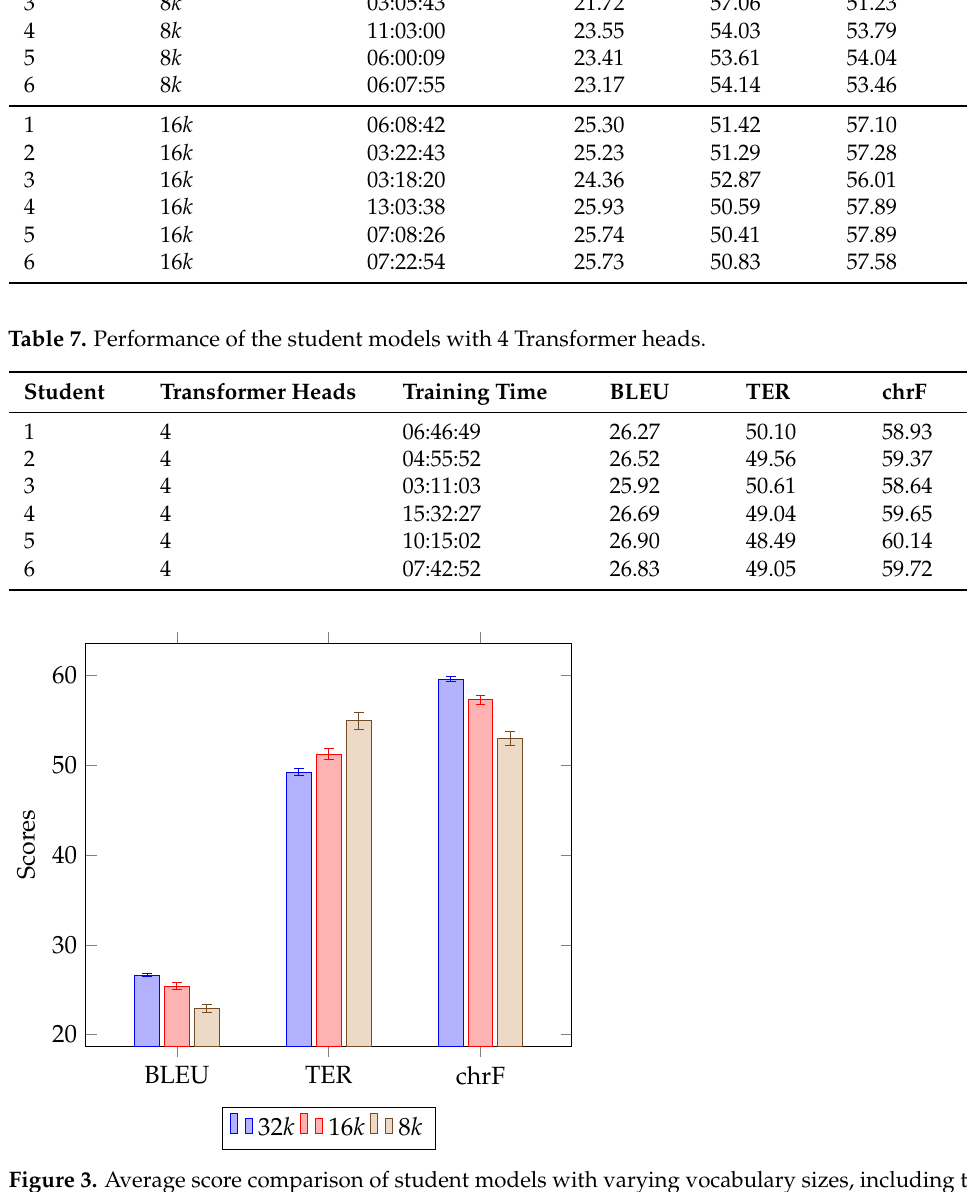
Figure 3. Average score comparison of student models with varying vocabulary sizes, including the standard deviations. Note that BLEU and chrF are precision-based metrics, so the higher the score the better, whereas TER is an error metric, so lower scores indicate better